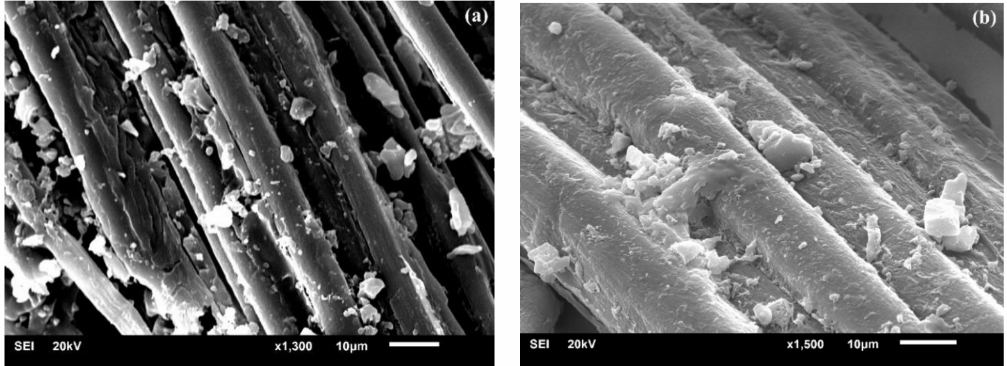
Figure 3. SEM images of surface morphology of composites: ( a ) before alkali treatment; and ( b ) after alkali treatment.